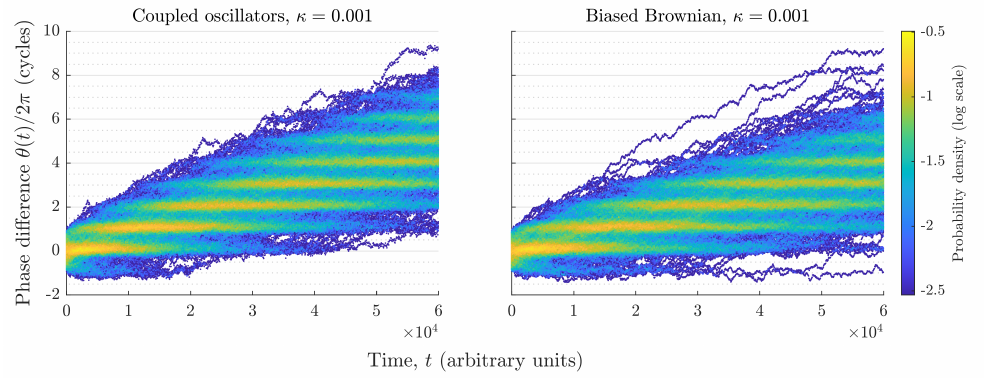
Figure 10. Probability density function of θ ( t ) over time for ( left ) deterministic and ( right ) stochastic ( Θ t ) models for κ = 0.001 and the same initial conditions. The randomness if higher than in the case of the uncoupled oscillators.